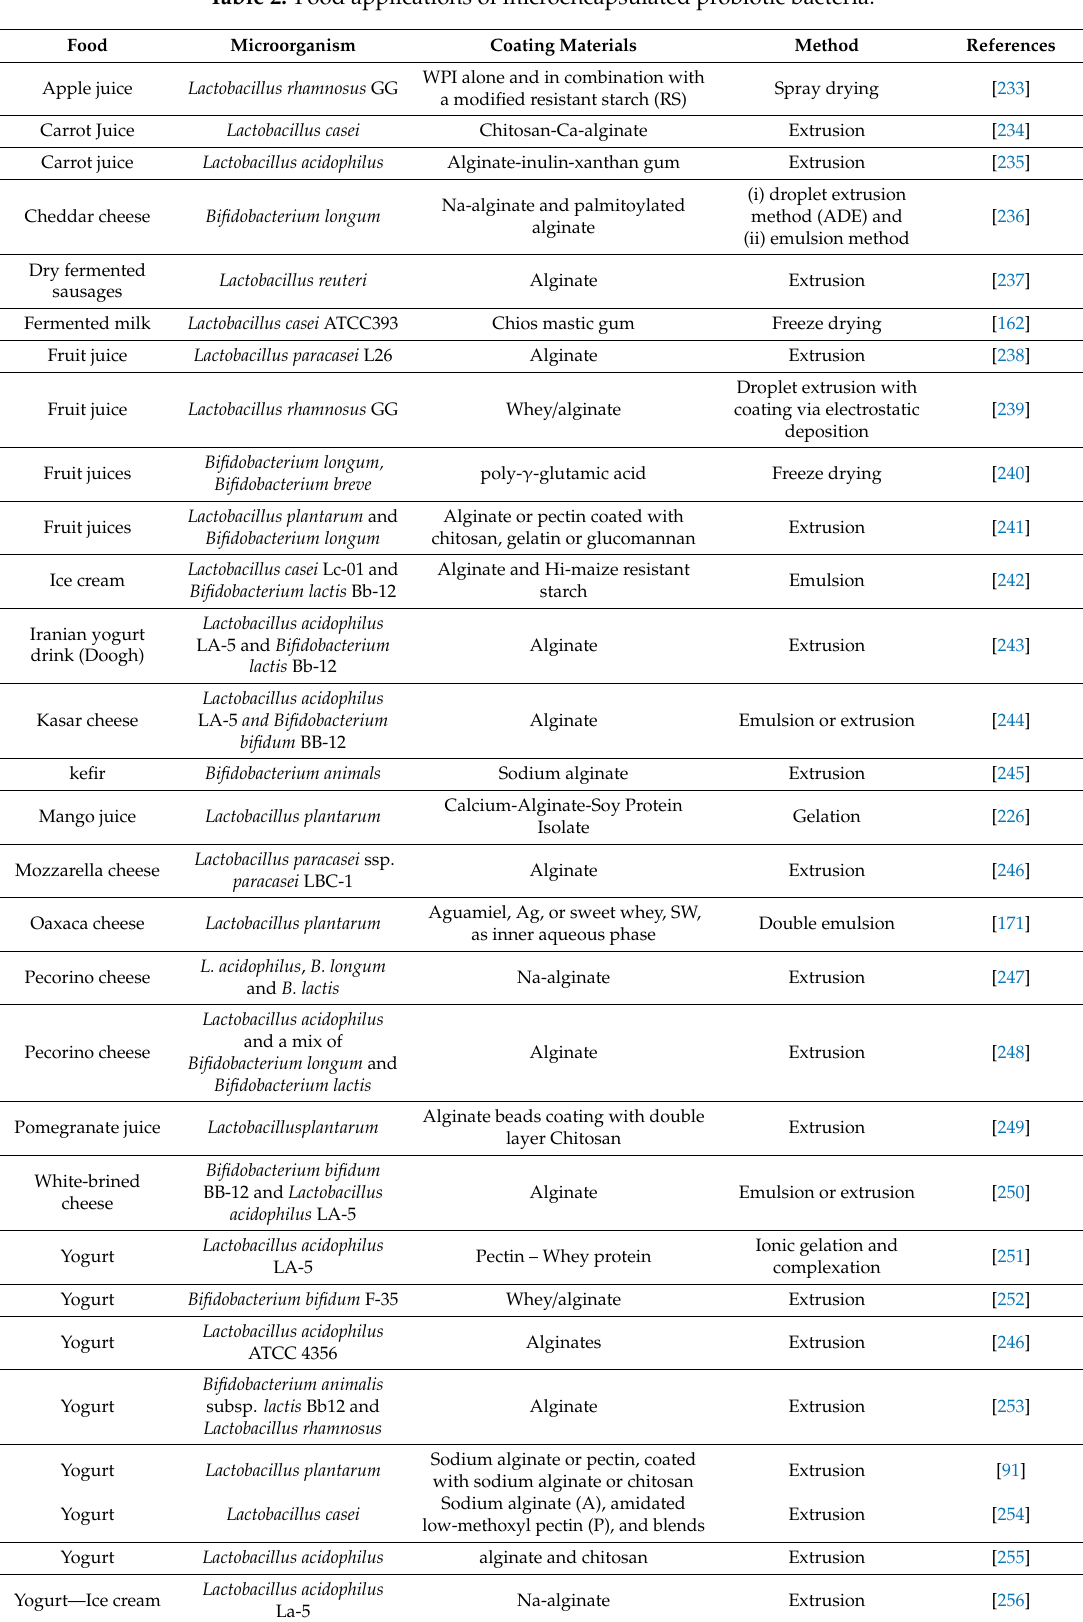
Table 2. Food applications of microencapsulated probiotic